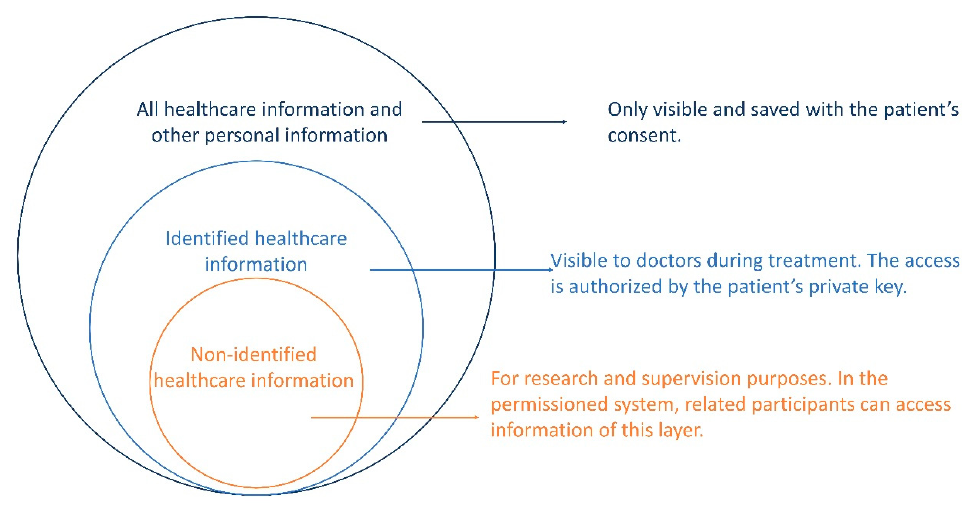
Figure 3. Hierarchical access control for privacy-preserving design.